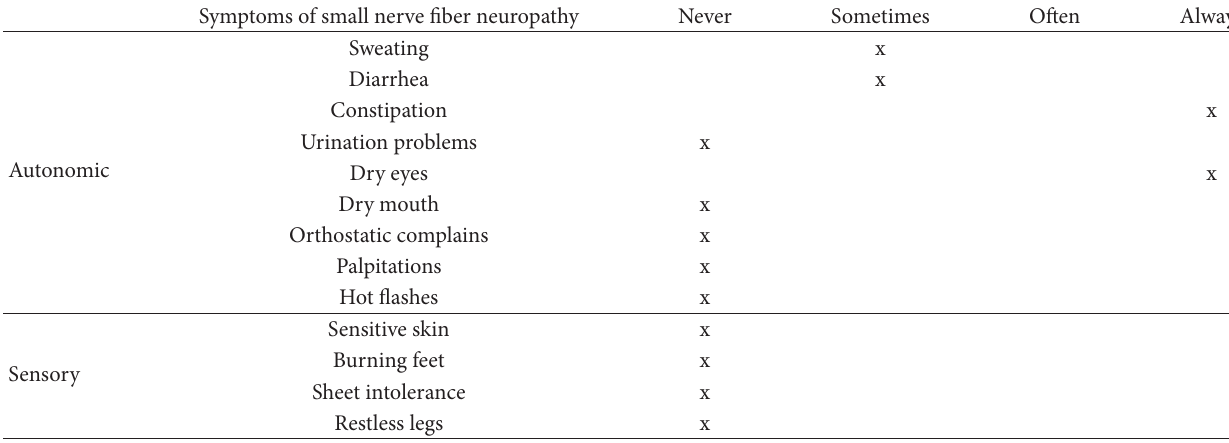
Table 2: Small nerve fiber symptom inventory questionnaire: responses of the patient described in this report are marked with x’s. The patient has some (0–3) symptoms of small fiber neuropathy.